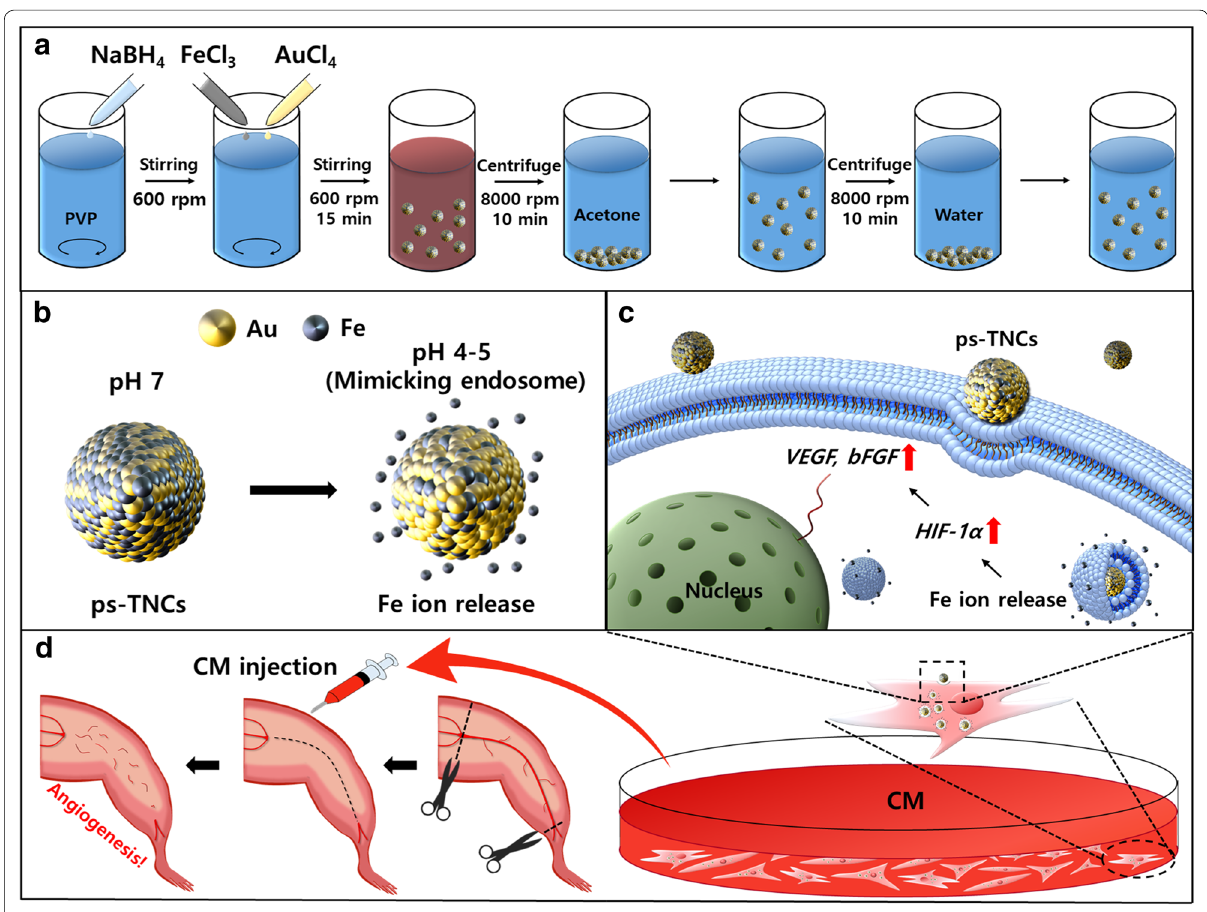
Fig. 1 Schematic of ps‑TNCs induced CM enhancement and therapeutic procedure. a Synthesis of ps‑TNCs. b Release of Fe ions under low pH condition, which mimics hADSC endosomes. c Uptake of ps‑TNCs through hADSCs endocytosis. d Therapeutic efficacy by in vivo enriched CM